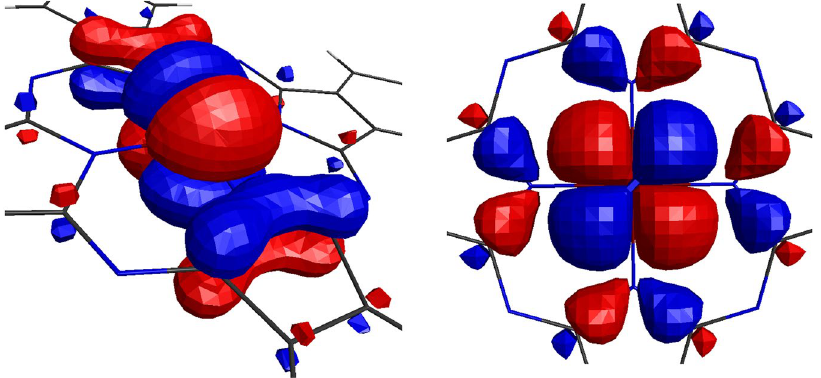
Figure 2. The figures of 3d orbitals. e g (left) and b 2 g (right) orbitals are evaluated by SA-CASSCF(6,5). (Drawn by MacMolPlt 35